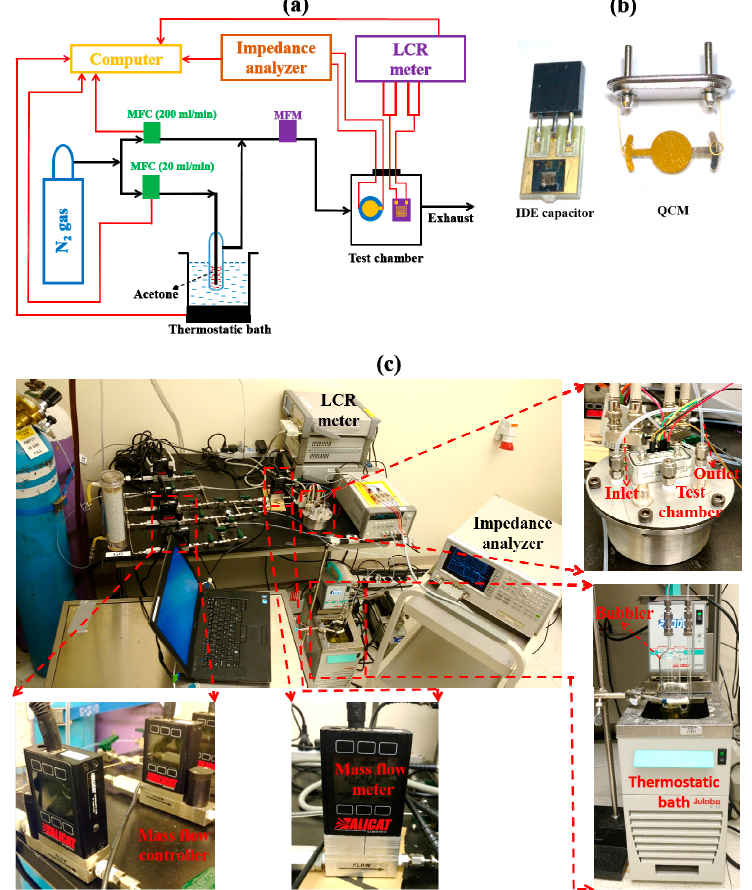
Figure 2. Experimental setup for gas sensing. ( a ) Schematic of the experimental setup used for characterizing and comparing the gas sensors. ( b ) Digital image of the capacitive and quartz crystal microbalance (QCM) substrates coated with ZIF-8 thins film. ( c ) Digital image of the experimental setup.